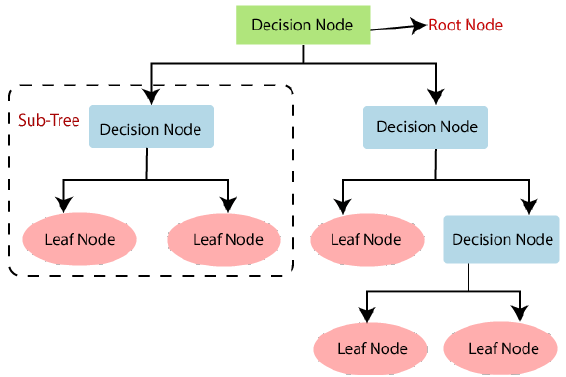
Figure 1. Structure of the decision tree (DT)